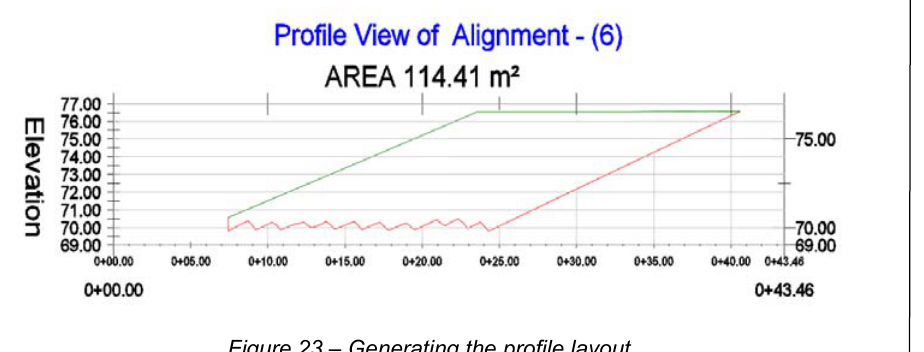
Figure 23 – Generating the profile layout Рис . 23 – Генерирование вида профиля